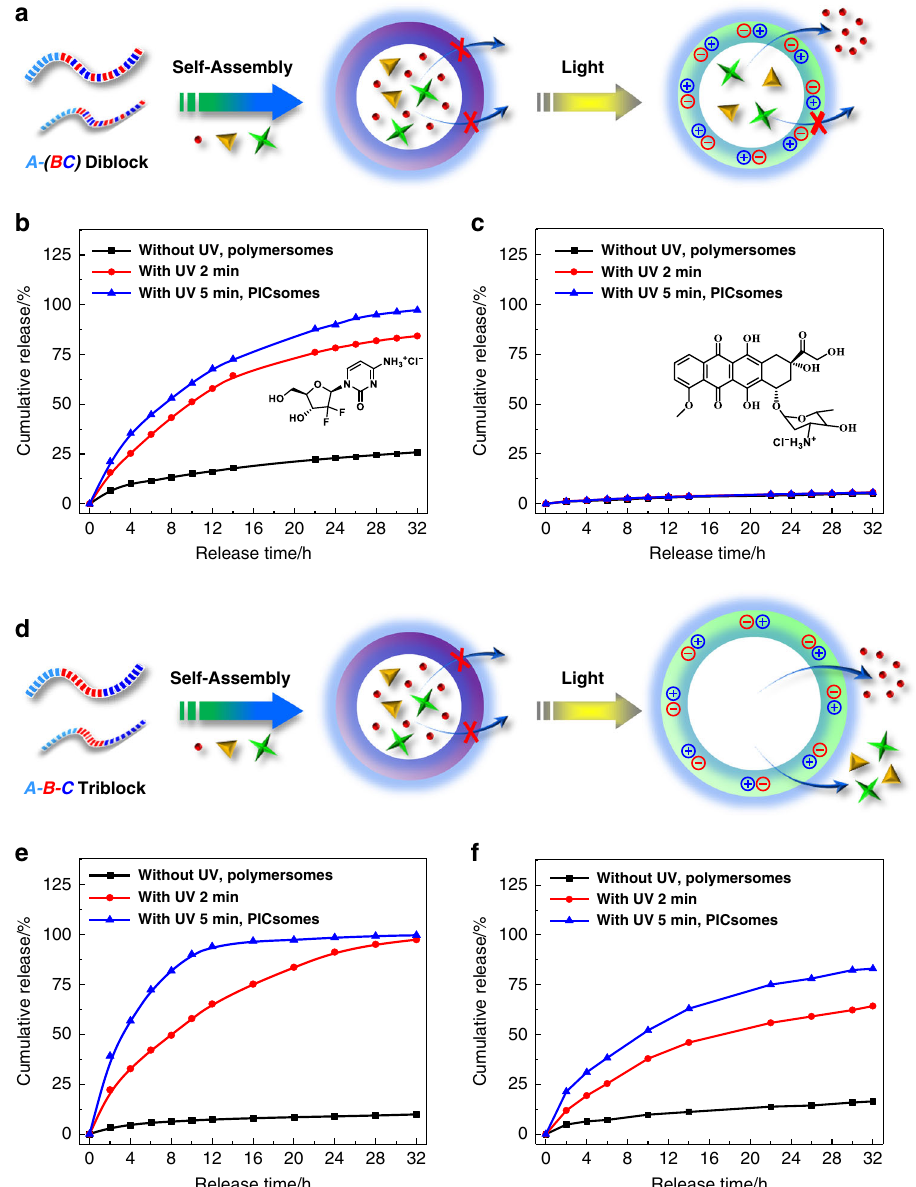
Fig. 9 Light-regulated polymersome-to-PICsome transition for molecular size-selective drug release. a , d Schematics of drug-loaded vesicles of PEO 45 - b -P(NCMA co -DPA b -PNCMA b -PDPA 0.55 - 0.45 ) 29 diblock copolymer a and PEO 45 - 17 - 21 triblock copolymer d , and triggered release from corresponding PICsomes. b , c , e , f Release pro fi les of encapsulated b , e gemcitabine hydrochloride and c , f Dox·HCl from the aqueous lumen of PEO 45 - b -P(NCMA 0.55 - co - DPA 0.45 ) 29 diblock copolymer b , c and PEO 45 - b -PNCMA 17 - b -PDPA 21 triblock copolymer e , f vesicles before and after UV irradiation. All data were